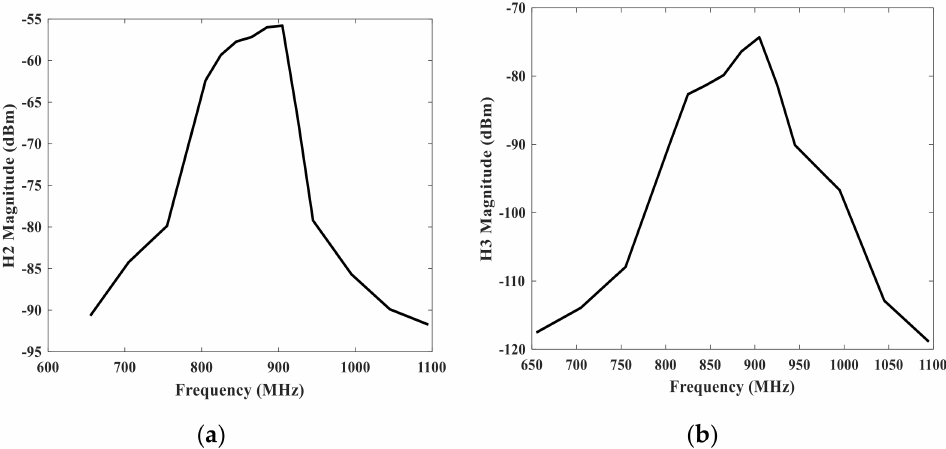
Figure 4. Results of harmonics of SAW resonators with nonlinear Mason equivalent circuit model. ( a ) the second harmonic response H2. ( b ) the third harmonic response